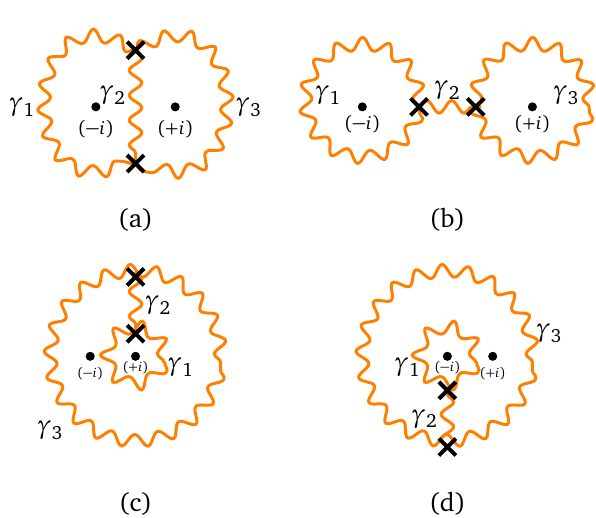
Figure 4.4: Four kinds of Strebel graphs with three punctures depending on the dif- ferent values of ( L ( −